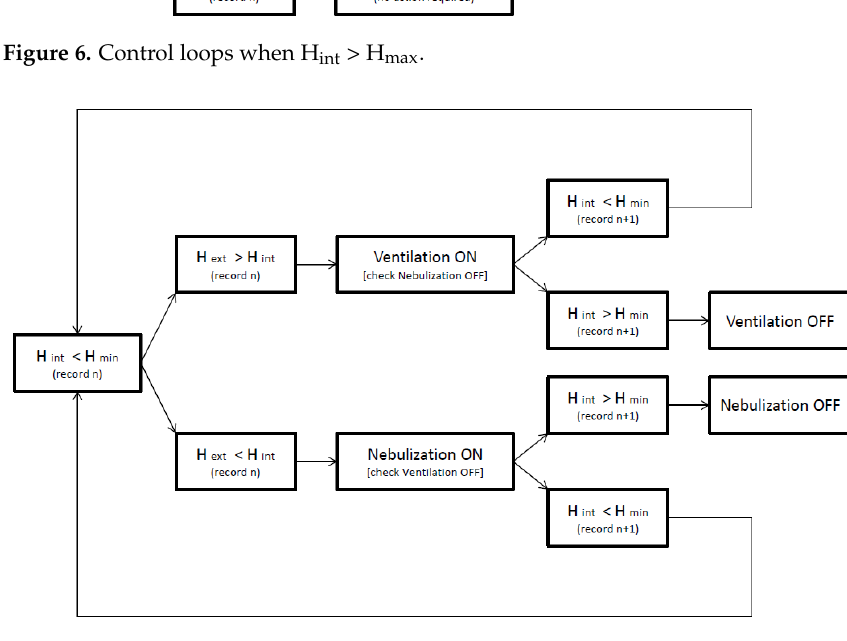
Figure 7. Control loops when H int <H min .